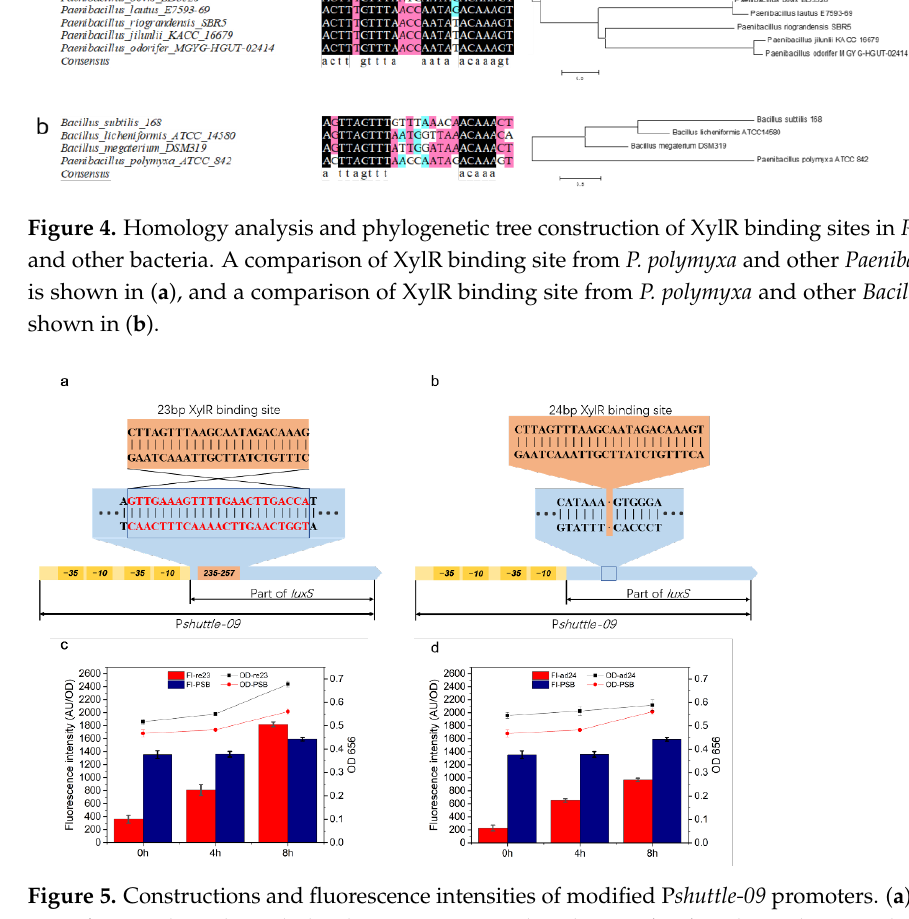
Figure 5. Constructions and fluorescence intensities of modified P shuttle-09 promoters. ( a ) Construc- tion of Psr23; the 23 bp XylR binding site was introduced into P shuttle-09 by replacing 23 bp se- quence. ( b ) Construction of Psa24; the 24 bp XylR binding site was introduced into P shuttle-09 by inserting it between 303 bp and 304 bp bases. The fluorescence intensities of P. polymyxa carrying plasmid with Psr23 and Psa24 are shown in ( c ) and ( d ).